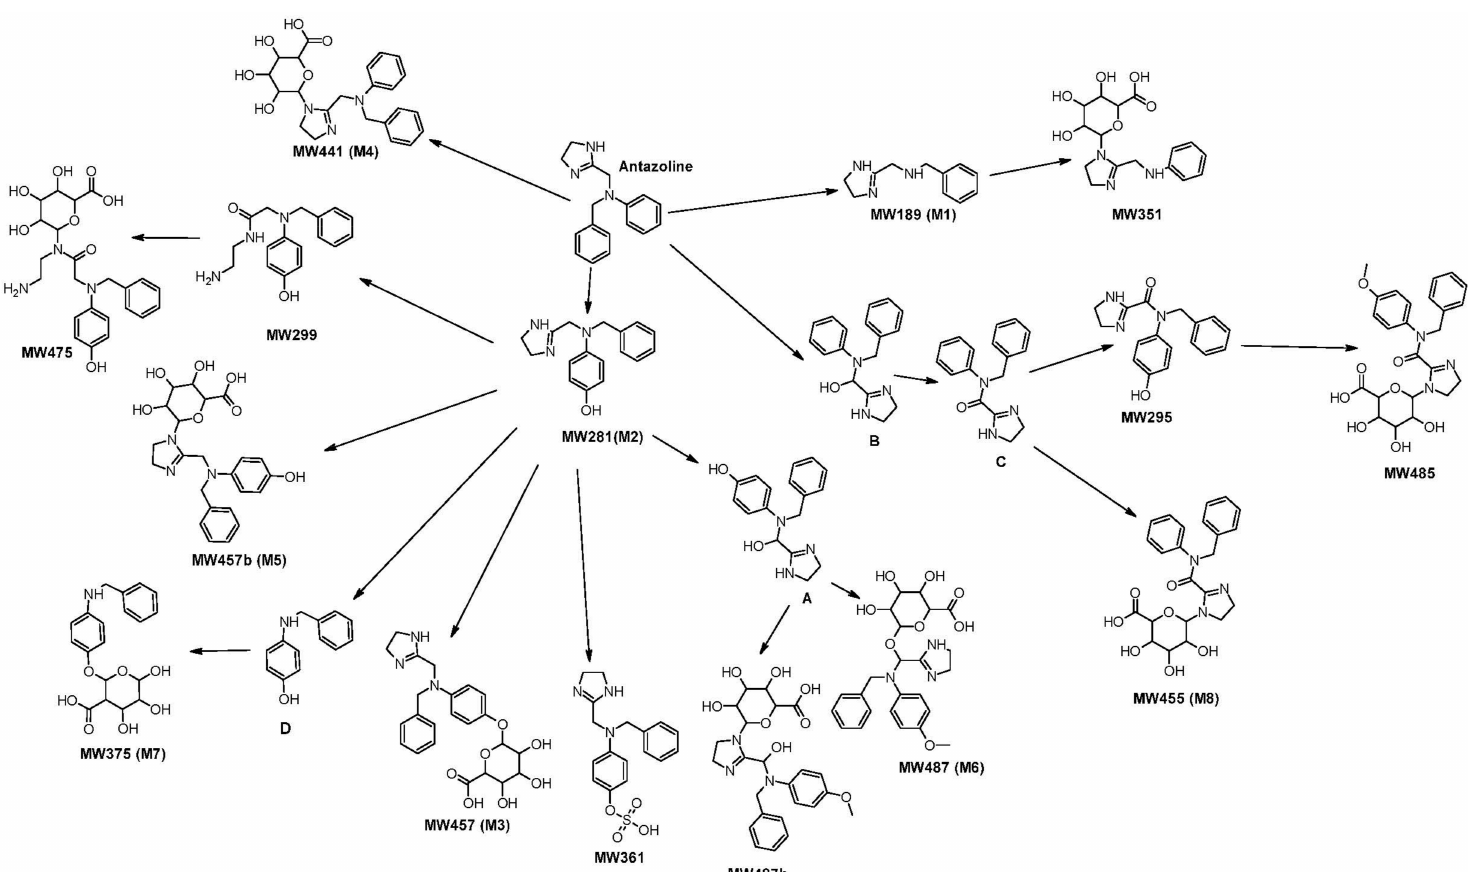
Figure 2. The main pathways of ANT metabolism and putative structure of Phase I and Phase II metabolites. The main metabolites are marked as M1 – M8 , other metabolites are labelled with molecular weights (MW). Possible intermediate products were marked A–D. A —monoisotopic mass: 297.1477 Da, detected in the plasma of volunteers but did not fulfill the criteria of metabolite selection (see Section 2.2); B —monoisotopic mass: 281.1528 Da, not detected in the plasma of volunteers, but detected in CYP in vitro metabolism study (CYP2C19), C —monoisotopic mass: 279.1371 Da, detected in the plasma of volunteers but did not fulfill the criteria of metabolite selection (see Section 2.2), D —monoisotopic mass: 199.09971 Da, not detected in this study, but described by Ali et al.